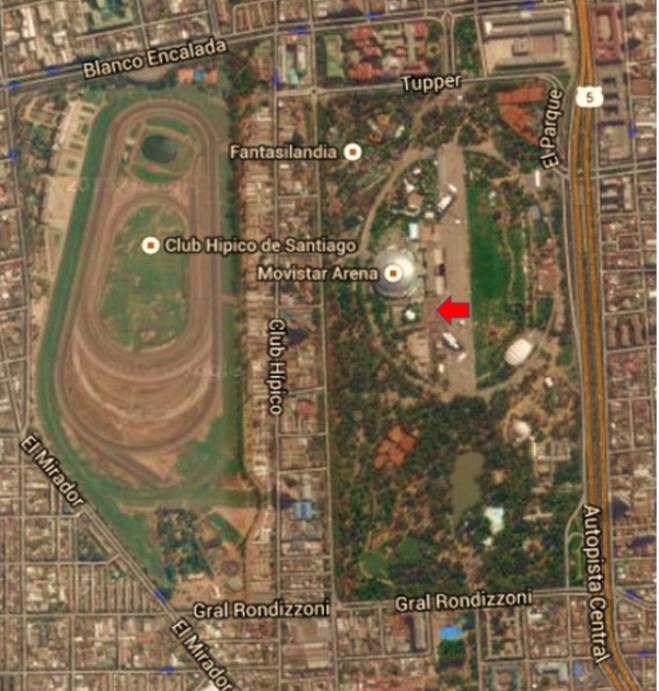
Figure 1. Satellite map of the “Club Hípico de Santiago”. The monitoring station “Parque O’Higgins” is indicated in red. The image was obtained from the Google maps site https://www.google.cl/maps (accessed on 13 March 2022).